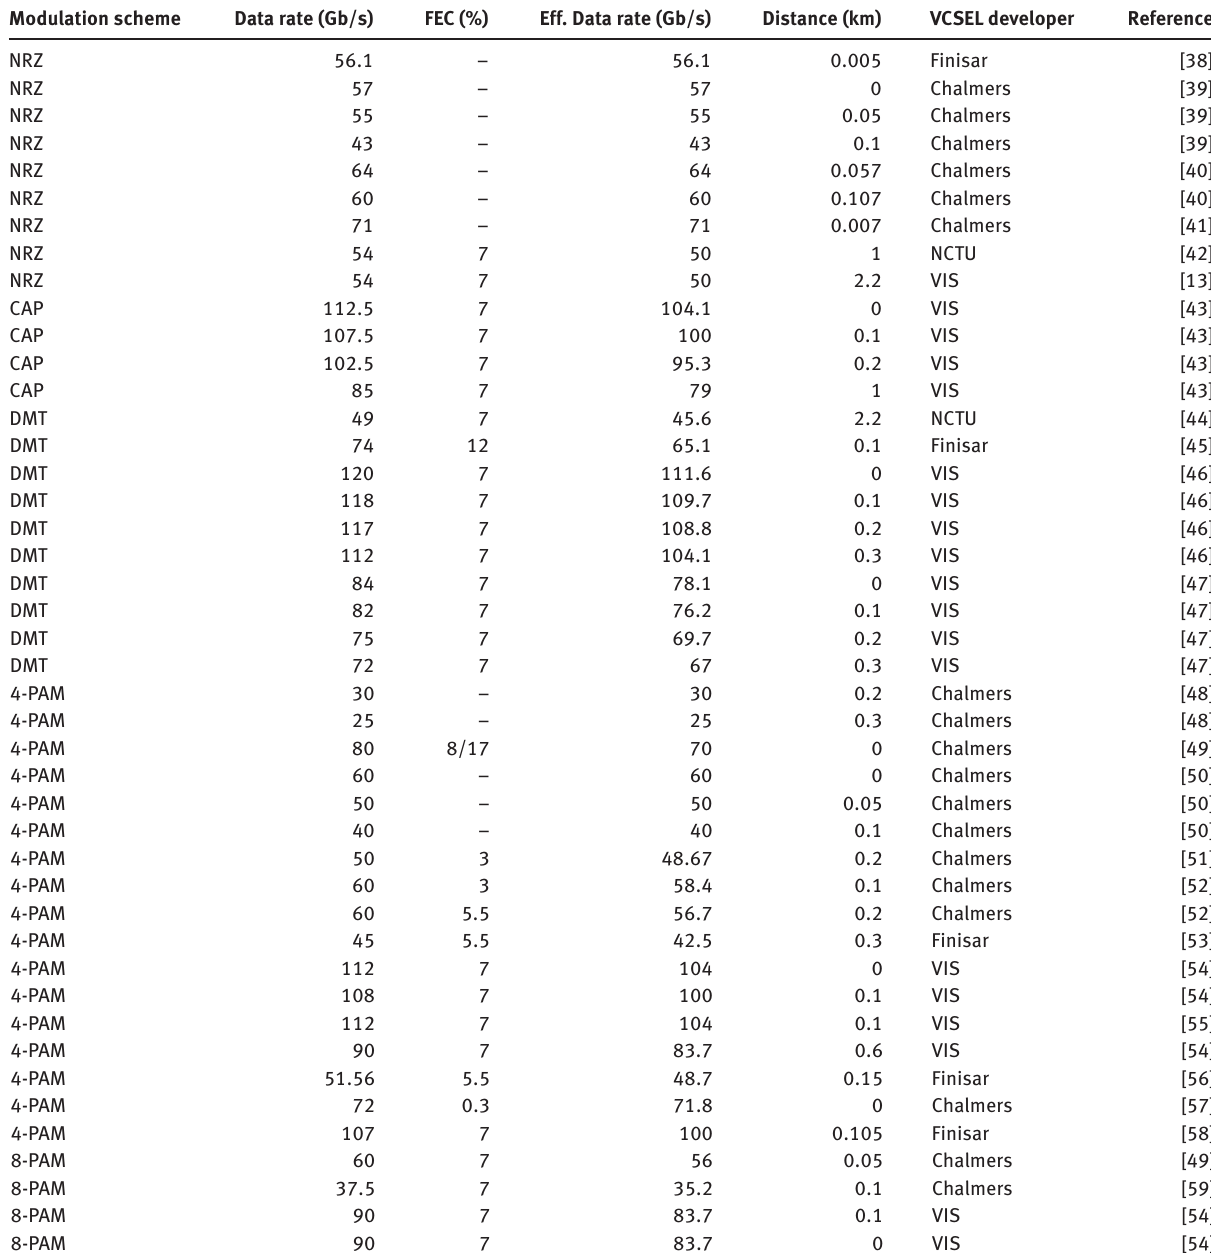
Table 1 : Data and references used in Figures 14 and